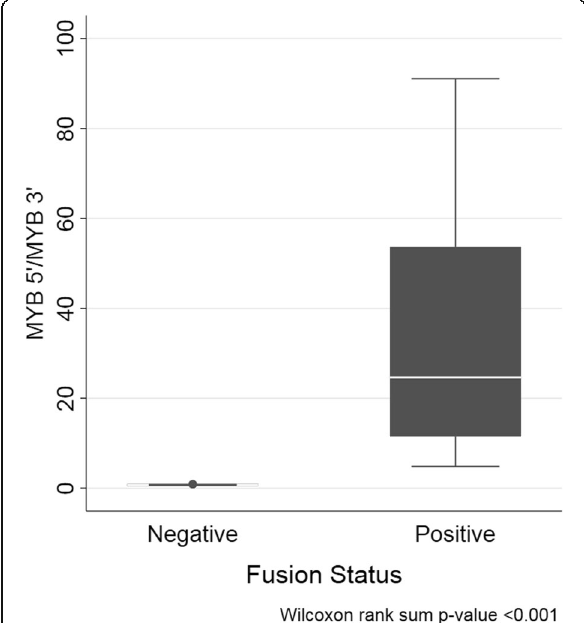
Fig. 1 Box plots representing MYB 5 ′ /3 ′ transcript ratios in MYB fusion negative ACC and MYB fusion positive ACC using NanoString digital probe-based